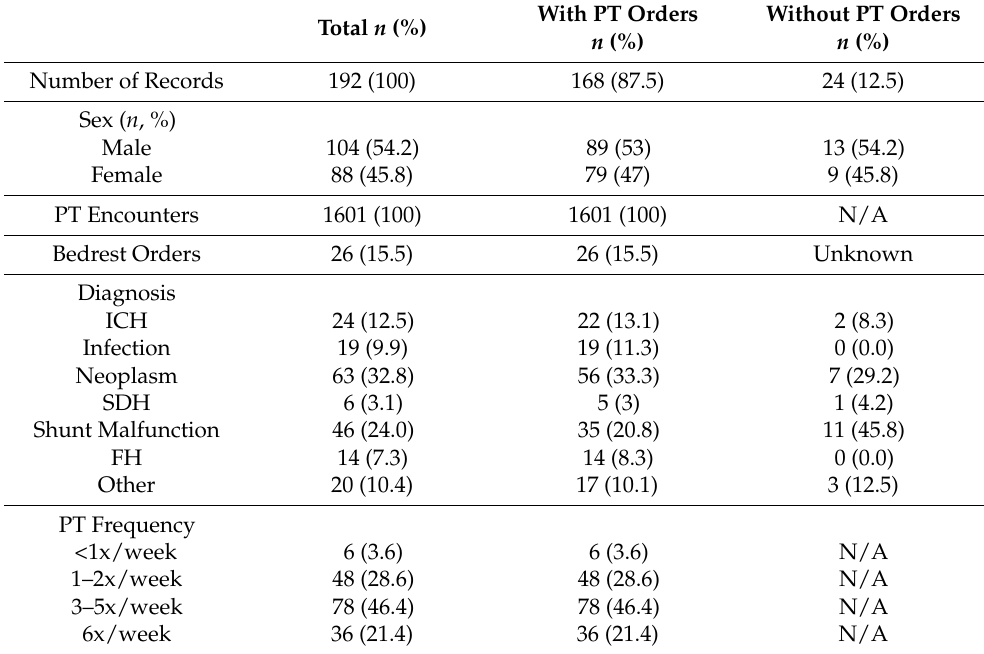
Table 1. Demographics of Patients with External Ventricular Drains.